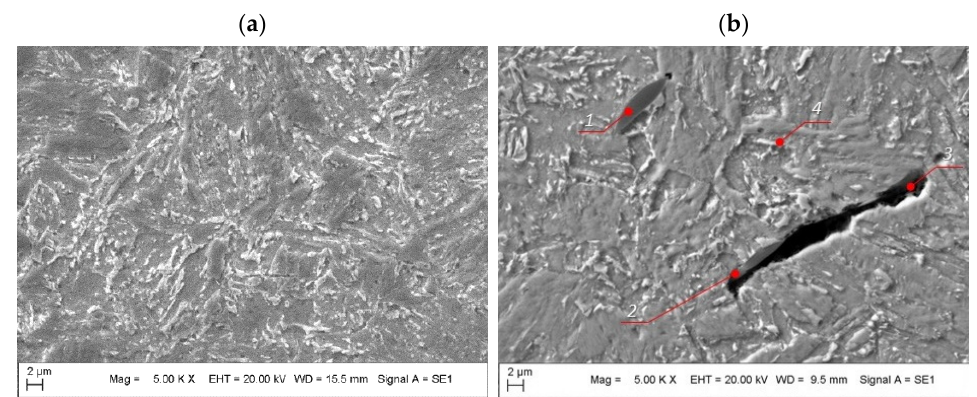
Figure 8. Images of the microstructure of the M789 maraging steel, which are either: ( a ) solution annealed and aged 6 h or ( b ) solution annealed and aged 9 h. Here, at positions 1 and 2, massive precipitates are seen at the grain boundary and secondary porosity, a cavity is found at the border of the melting track at position 3, and the retained austenite (lighter color) is seen between the martensite plates at position 4.